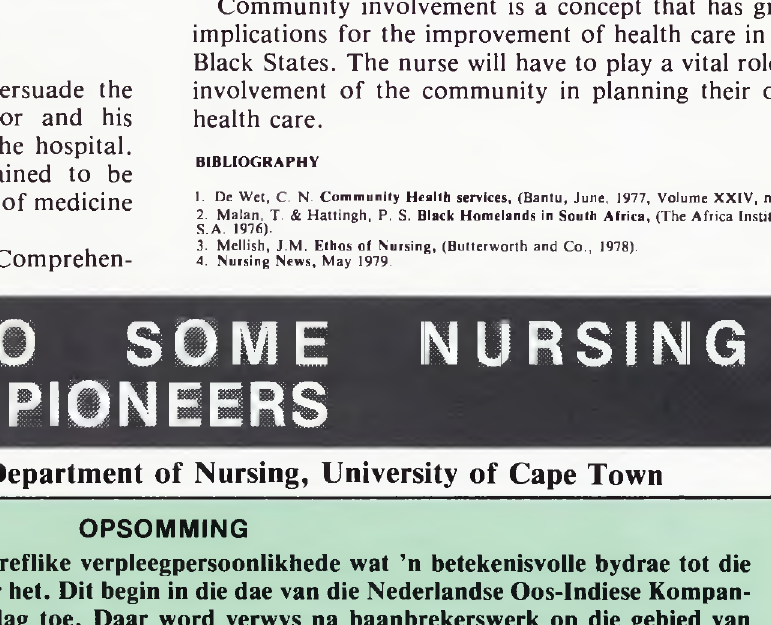
’n Oorsig van sommige van die voortreflike verpleegpersoonlikhede wat ’n betekenisvolle bydrae tot die verpleegberoep in Suid-Afrika gelewer het. Dit begin in die dae van die Nederlandse Oos-Indiese Kompan- jie se regering aan die Kaap tot vandag toe. Daar word verwys na baanbrekerswerk op die gebied van verloskunde, psigiatrie- en algemene verpleging, verpleegonderwys en professionele ontwikkeling. Daar word ook kommentaar gelewer oor Swart en Kleurlingbaanbrekersverpleegsters en die bydrae van sen-